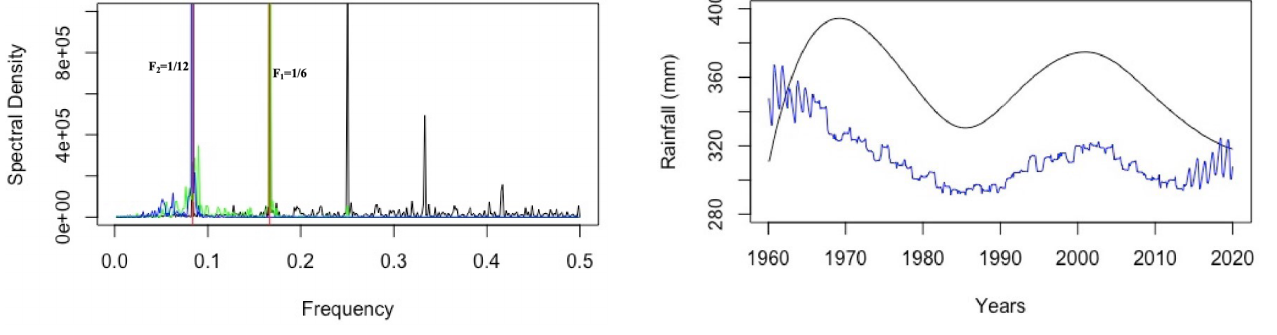
Figure 14. Rainfall IMF 1 (black line), IMF2 (green line), and IMF3 (blue line) spectral contents.